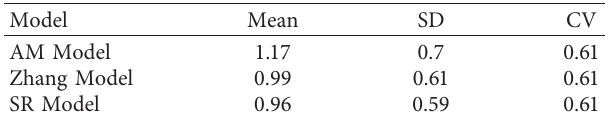
Table 8: The statistics of calculated ε under adhesive-FRP interface failure